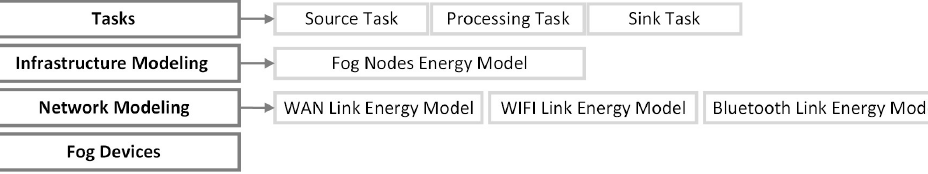
Figure 6. LEAF Architecture (Adapted from